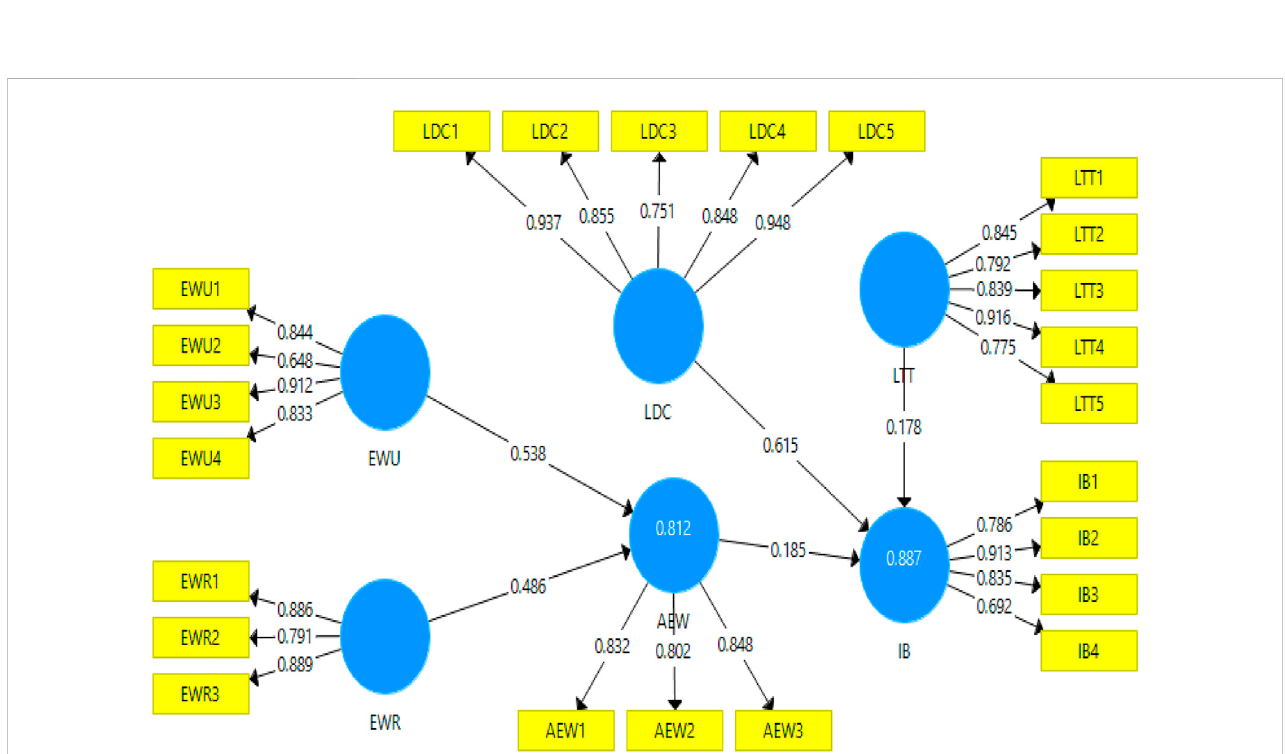
FIGURE 2 Measurement model. EWU, E-wallet Usefulness; EWR, E-wallet Risk; AEW, Adopting E-wallet; IB, Impulsive Buying; LDC, Low Distribution Charges, and LTT, Low Transit